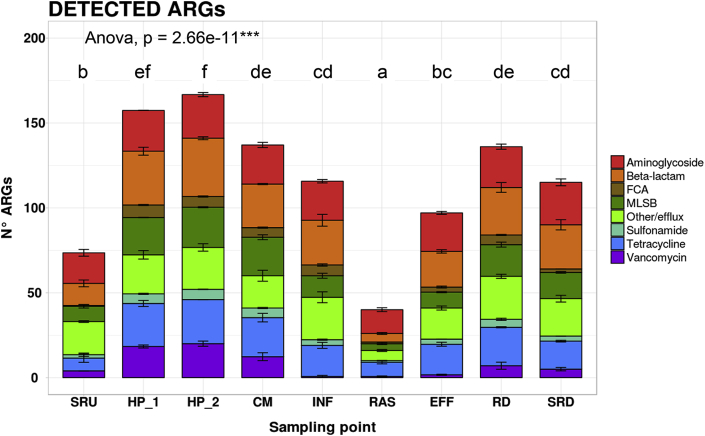
Number of antibiotic resistance genes (ARGs) detected in the sampling sites. Resistance genes are classified based on the antibiotics to which they confer resistance. They include aminoglycosides, β-lactams, FCA (fluoroquinolone, quinolone, florfenicol, chloramphenicol and amphenicol resistance genes), MLSB (macrolide-lincosamide-streptogramin B), other/efflux (multidrug-efflux pumps or others), sulphonamides; tetracyclines; and vancomycin. The statistical analyses, comparing the number of resistance genes in each site were performed using one-way analysis of variance (ANOVA) and post-hoc Tukey test.